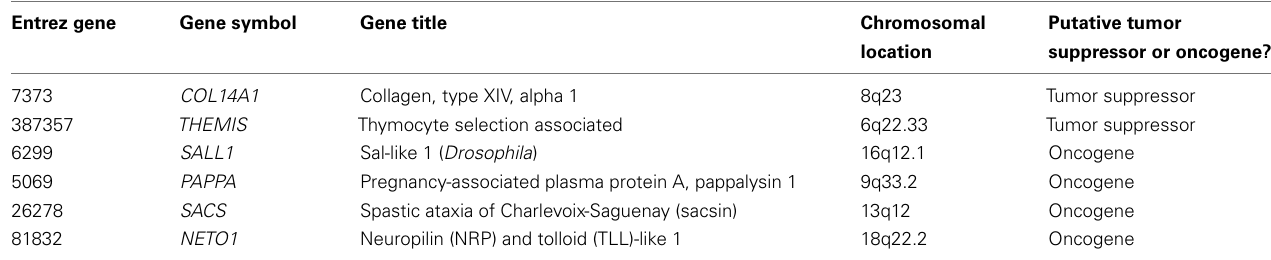
Table 1 | Four putative melanoma oncogenes and two putative tumor suppressor genes derived from the amalgamated